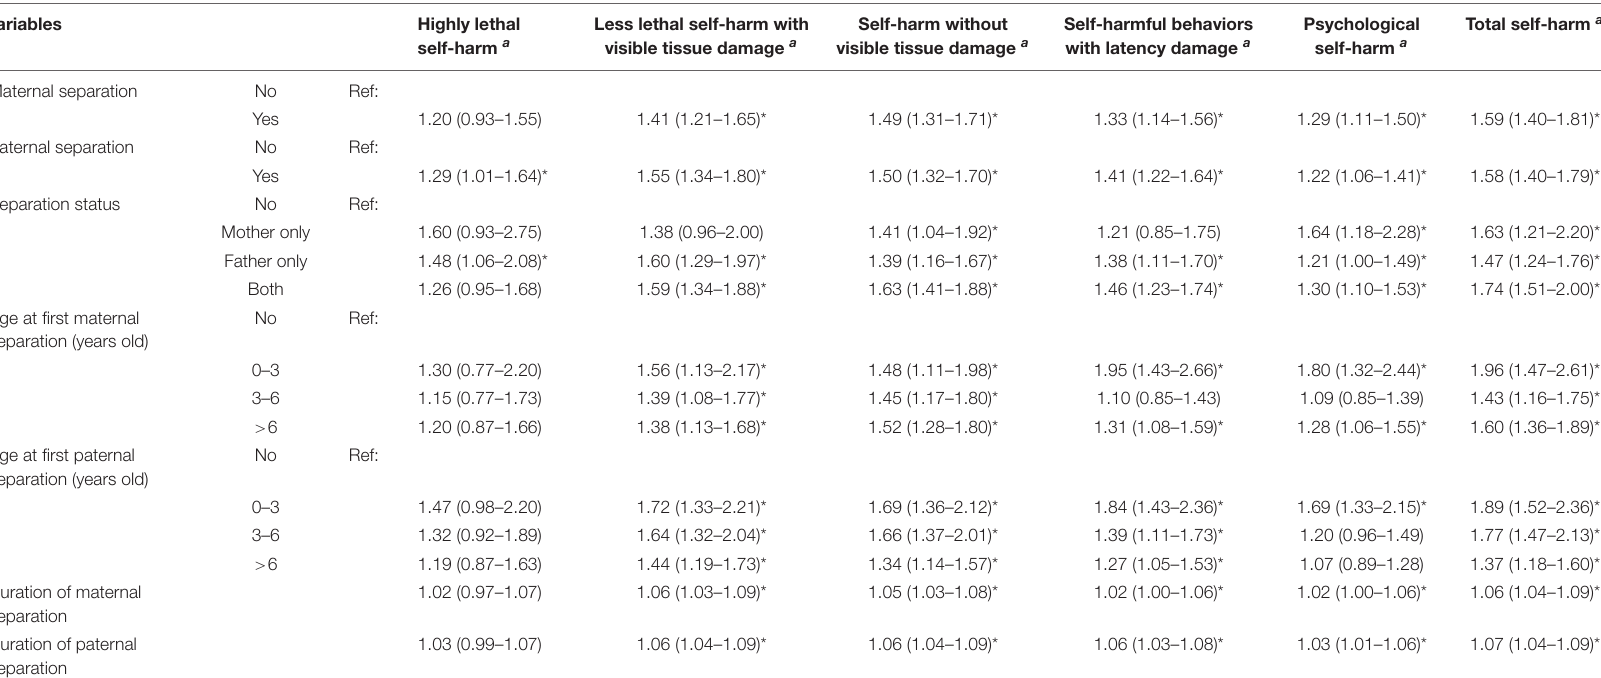
TABLE 3 | Multivariable logistic regression analysis showing the AOR (95% CI) between parent-child separation and five subtypes of self-harm. Variables